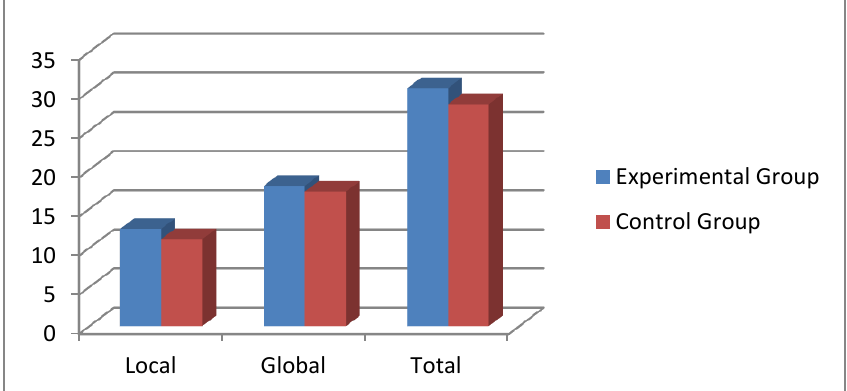
Figure 2. The Comparison of the Means from the Writing Test in Terms of Local and Global Issues in Experimental and Control